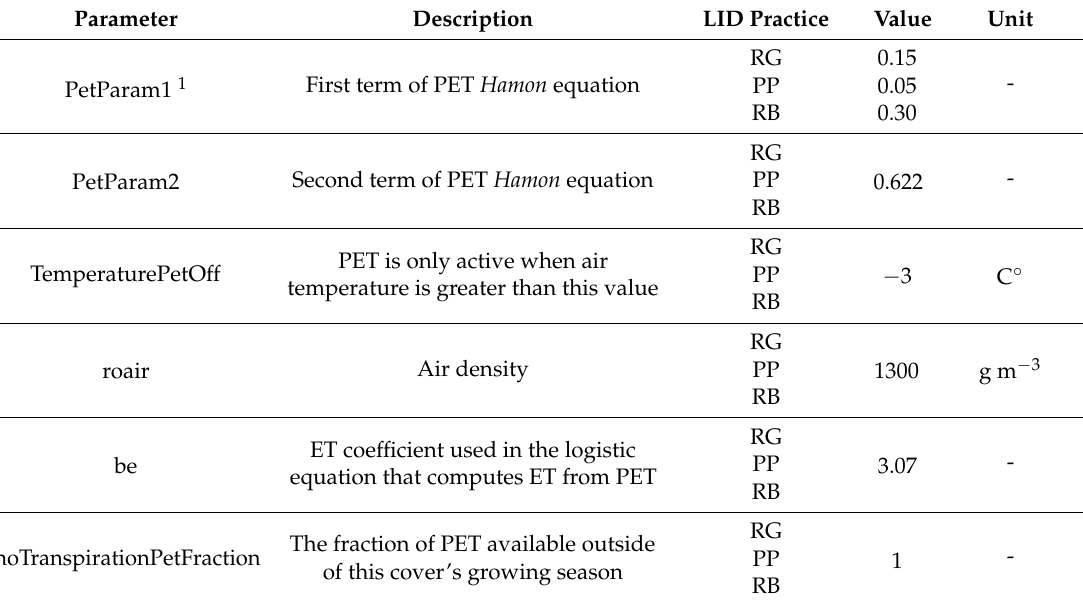
Table 7. Potential Evapotranspiration parameter values used in the LID practice scenarios. RG: Rain Garden, PP: Permeable Pavement, and RB: Riparian